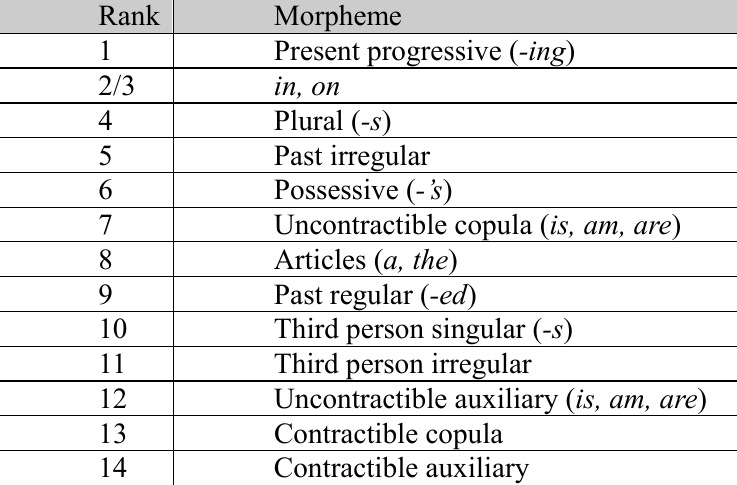
Order of L1 Acquisition of English Morphemes in R. Brown (1973)